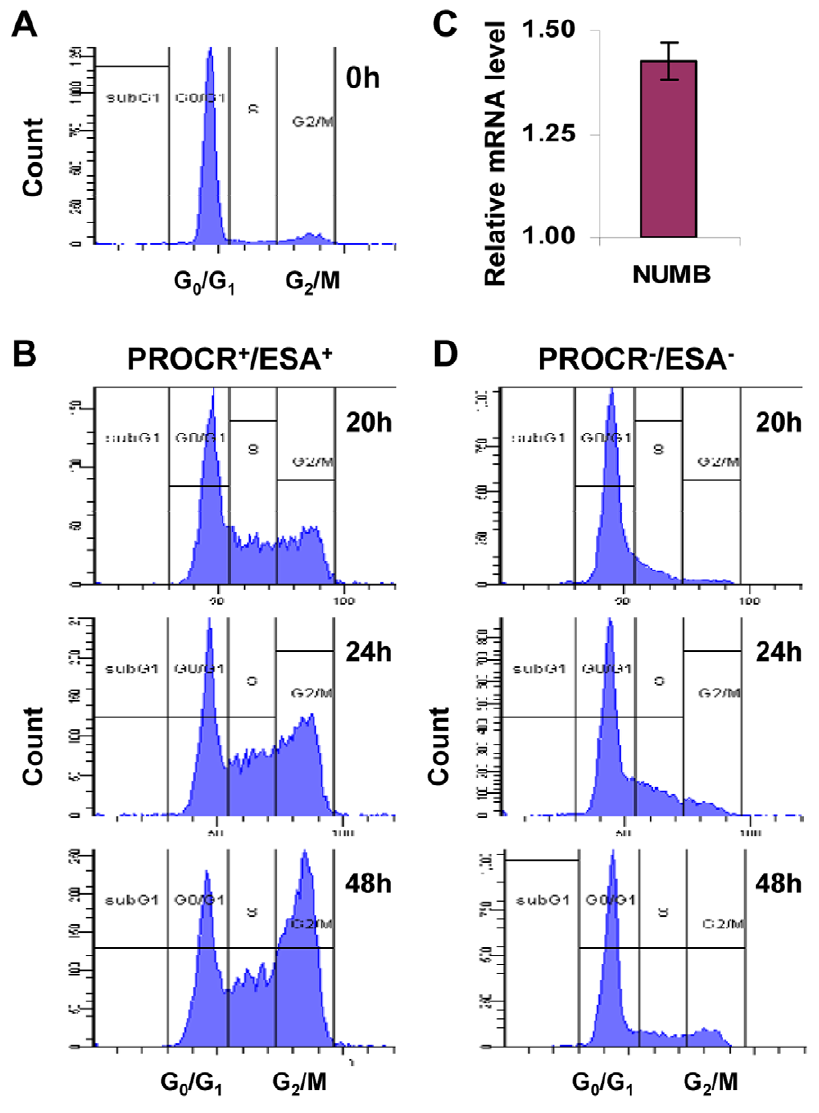
Figure 3. Cell cycle profiling and NUMB expression of PROCR + /ESA + and PROCR 2 /ESA 2 MDA-MB-231 cells. Bulk cells (A) were synchronized by serum starvation using DMEM supplemented with 0.5% FBS for 48 h. At 20, 24 and 48 h after release from serum starvation, PROCR + /ESA + (B) and PROCR 2 /ESA 2 (D) cells stained with propidium iodide and the cell cycle profile analyzed. C. The expression level of NUMB in PROCR + /ESA + relative to PROCR 2 /ESA 2 cells were assayed using real-time PCR. GAPDH was used as an internal control. Results are means 6 SD of triplicate experiments.